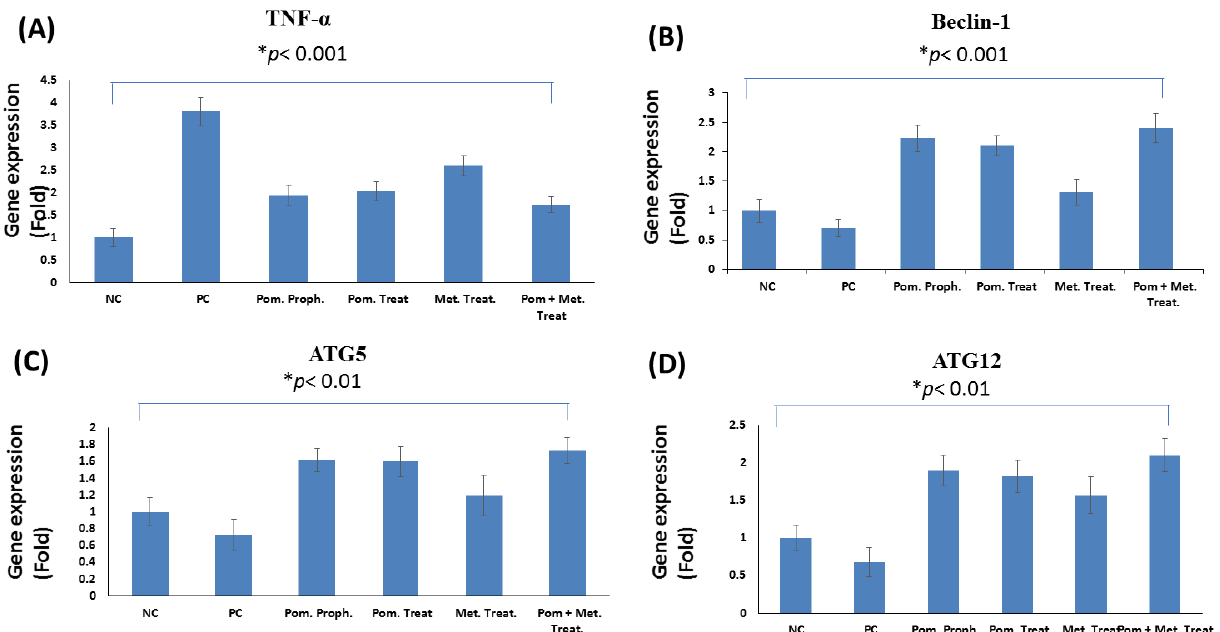
Figure 6. Effect of H. pylori infection, pomegranate extract (PEAME) and metronidazole on the mRNA expression levels of ( A ) tumor necrosis factor-alpha ( TNF - α ), ( B ) autophagy-related gene 5 ( ATG5 ), ( C ) autophagy-related gene 12 ( ATG12 ), and ( D ) Beclin1 in the stomach tissues of rats. Data are presented as mean ± SE, n = 3, significance level p < 0.05. NC: negative control (not infected), PC: positive control (infected with H. pylori ), Pom proph.: PEAME prophylactic group, Pom treat.: PEAME treated group, Met. treat.: metronidazole treated group, Pom + Met treat.: rats co-treated with PEAME and metronidazole.